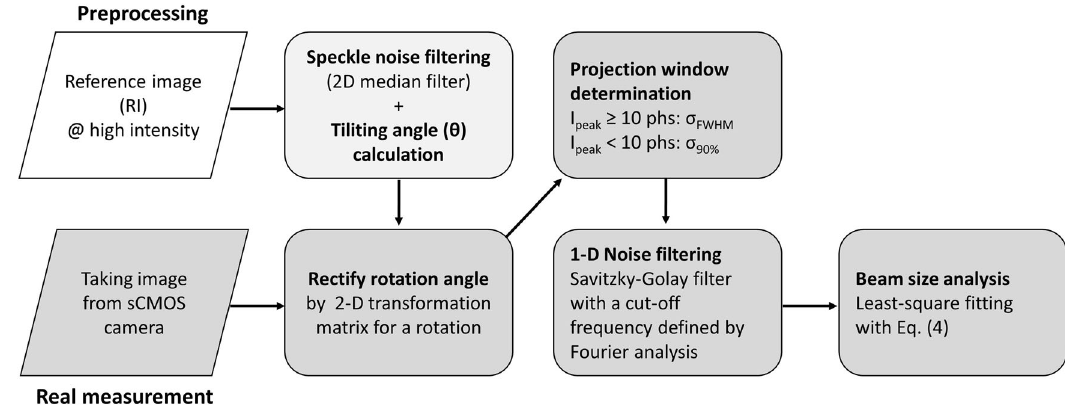
Fig. 3 Flow chart of the signal processing algorithm for a low-intensity interferometry beam size monitor (IBSM) data. The diagnostics use a scienti fi c complementary metal – oxide – semiconductor (sCMOS) camera to detect interferometry fringes at a low photon intensity.